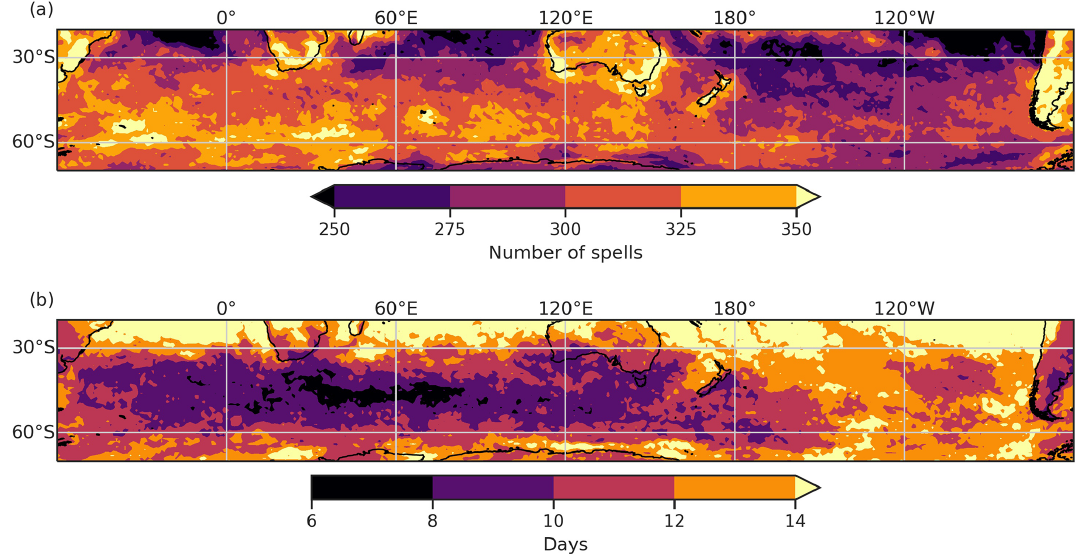
Figure 2. (a) Total number of hot spells in November–April identified at each grid point between 20 and 70 ◦ S. (b) The 95th percentile of hot-spell durations in